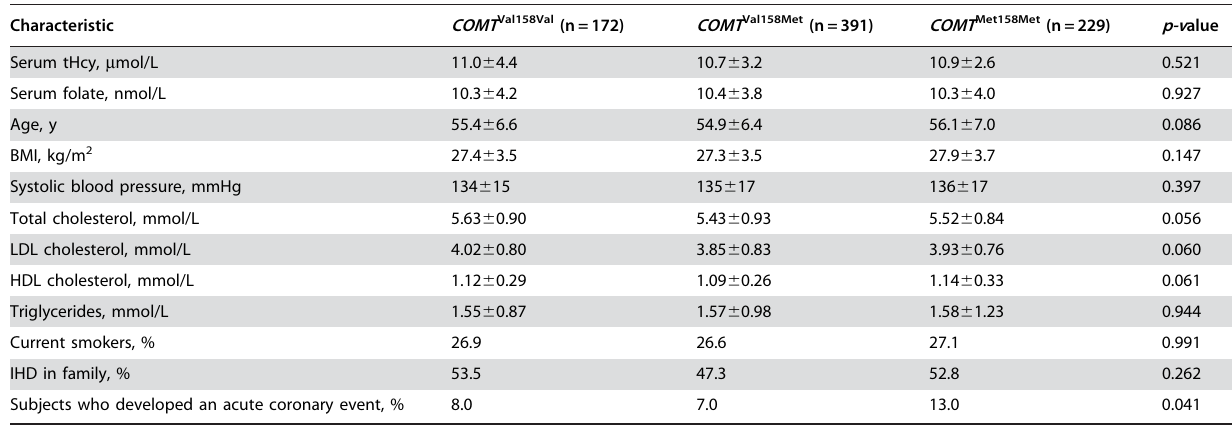
Table 2. Characteristics of the study subjects according to the catechol-o-methyltransferase ( COMT ) genotypes * .. ... .... ... ... .... ... ... .... ... ... .... ... ... .... ... ... .... ... ... .... ... ... .... ... ... .... ... ... .... ... ... .... ... ... .... ... ... .... ... ... .... ... ... . Characteristic COMT Val158Val (n=172) COMT Val158Met (n=391) COMT Met158Met (n=229) p-value Serum tHcy, m